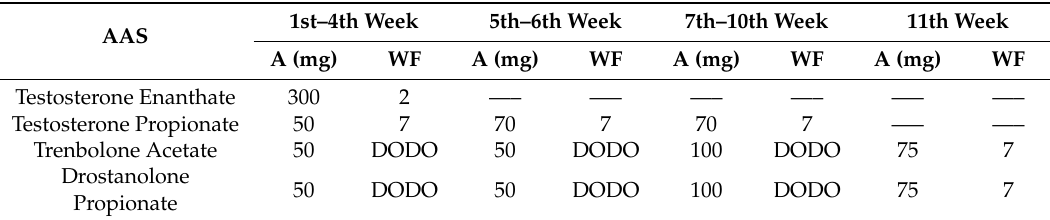
Table 1. The AAS (anabolic androgenic steroids) self-administered during the 11